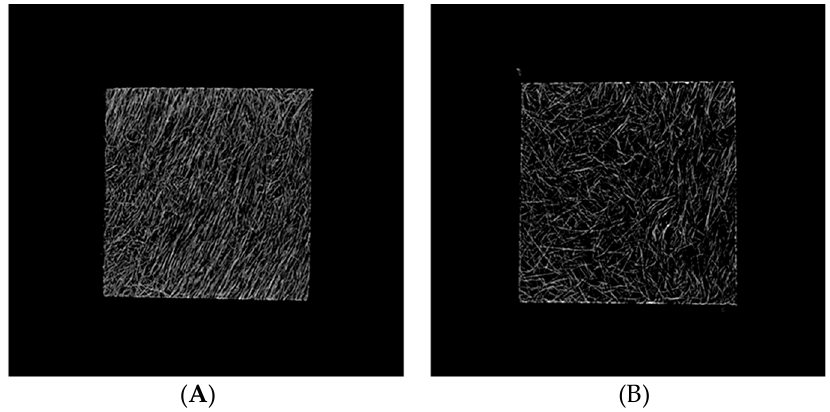
Figure 7. Micro-CT images of plate specimens: ( A ) solid specimen and ( B ) MCP-applied specimen.